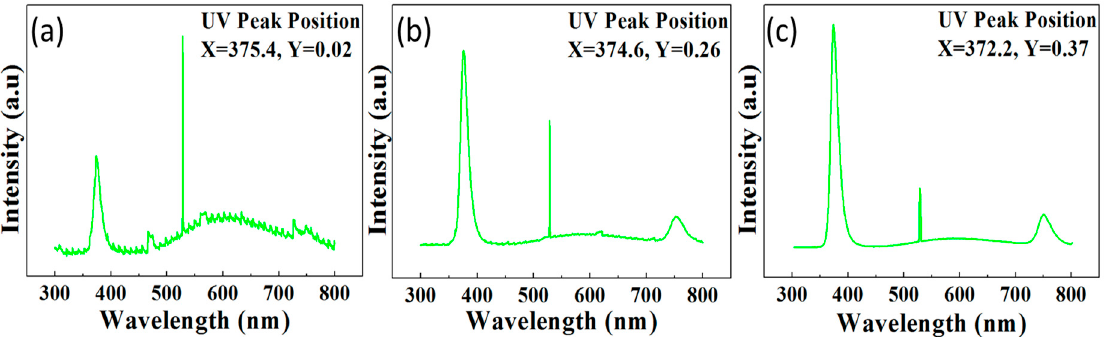
Figure 7. PL spectra of ( a ) 1%; ( b ) 2%; and ( c ) 5% GZRs.